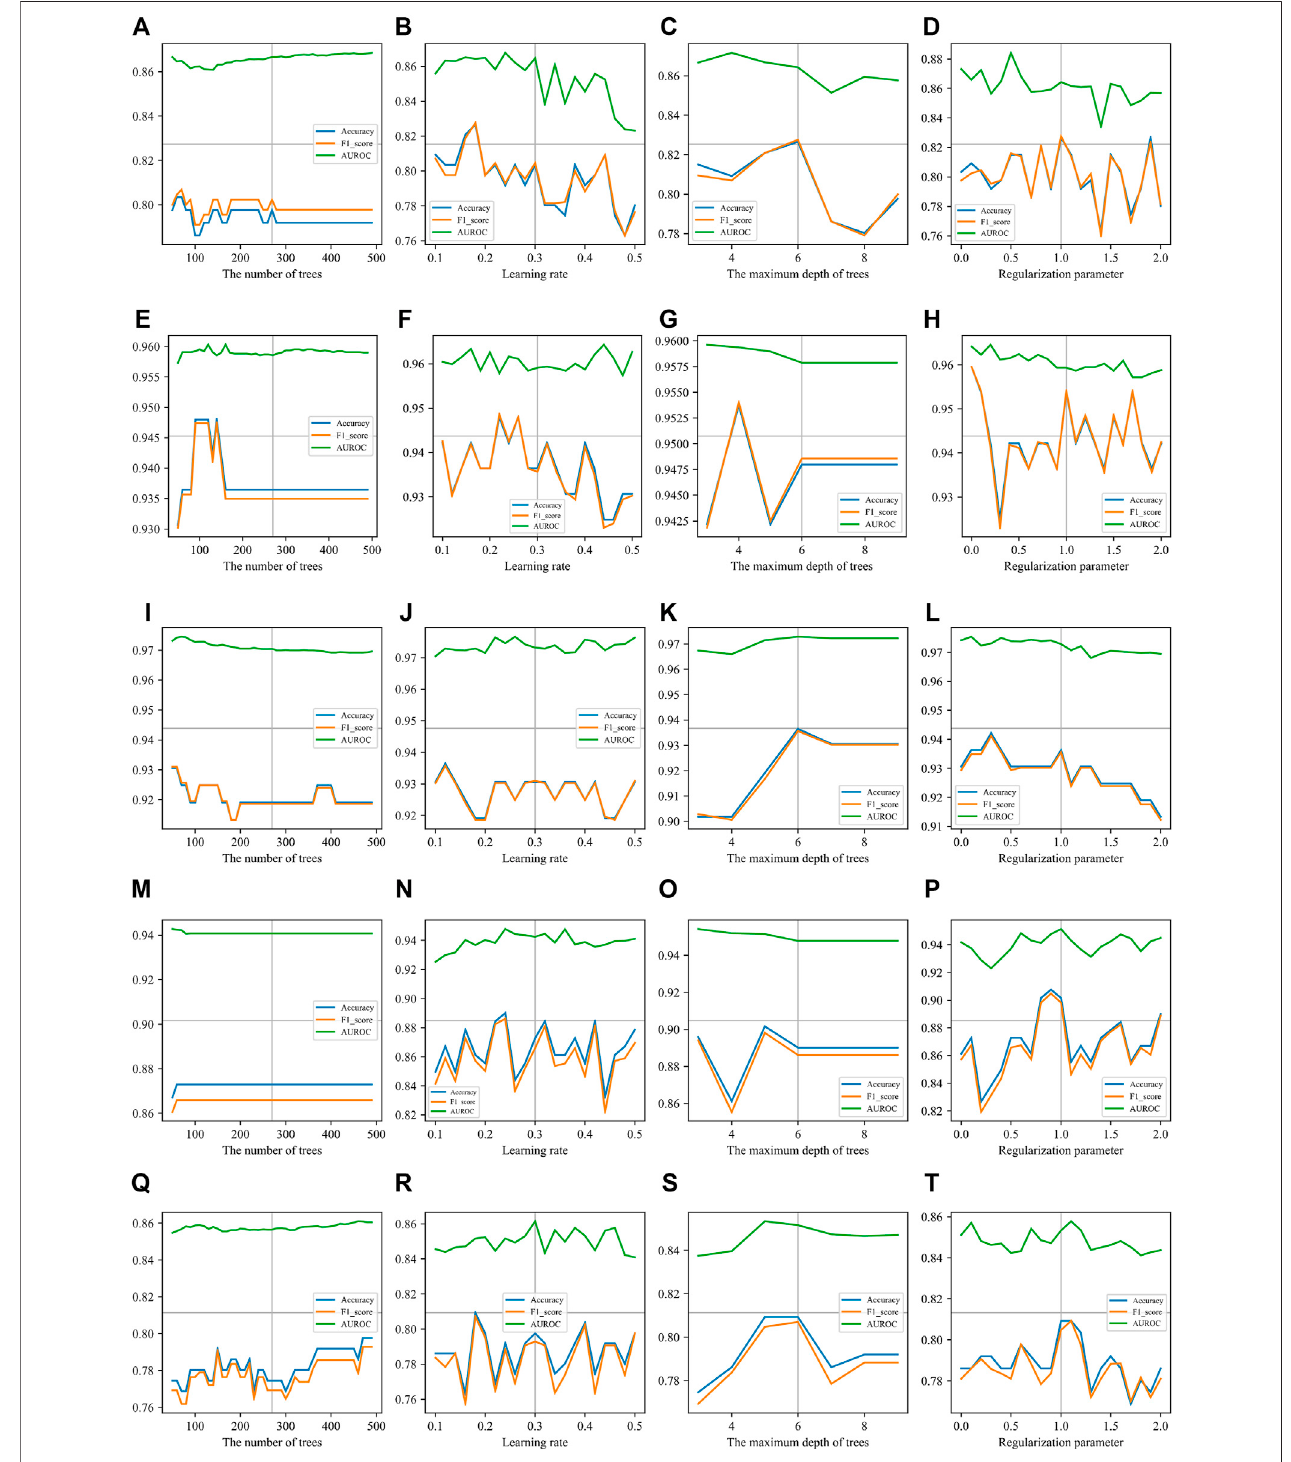
FIGURE 5 | Parameter effects on XGBoost with different types of features. Parameters of XGBoost are scanned. The accuracy, F1-score, and AUROC are presentedineachpanel.Thenumberoftrees (T) ,thelearningrate (R) ,themaximumdepthoftrees (D) ,andtheregularizationparameter( λ )arescannedoneachtypeof sequence features. (A), (B) , (C) , and (D) are scanning parameters on k -mer features. The best parameter values are T = 60, R = 0.18, D = 6, and λ = 1. (E) , (F) , (G) , and (H) are scanning parameterson mismatch features. The best parameter values are T= 80, R= 0.22, D = 4, and λ = 0. (I),(J) , (K) , and (L) are scanning parameters on subsequence features. The best parameter values are T = 50, R = 0.12, D = 6, and λ = 0.3. (M) , (N) , (O) , and (P) are scanning parameters on Pse-DSSPC features. The best parameter values are T = 60, R = 0.24, D = 5, and λ = 0.9. (Q) (R) , (S) , and (T) are scanning parameters on triplet features. The best parameter values are T = 500, R = 0.18, D = 5, and λ =